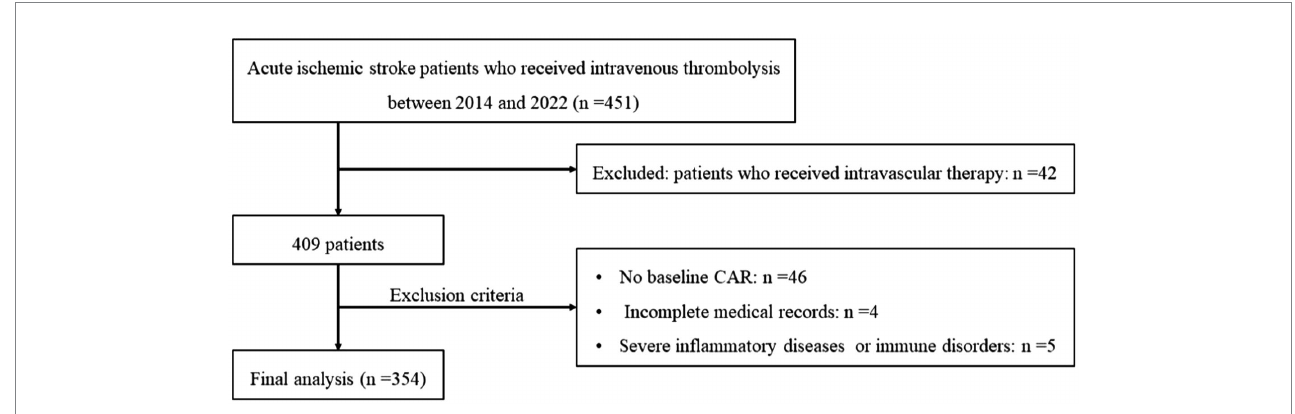
FIGURE 1 Flowchart of patient inclusion and analysis. CAR, ratio of C-reactive protein to albumin; HT, hemorrhagic